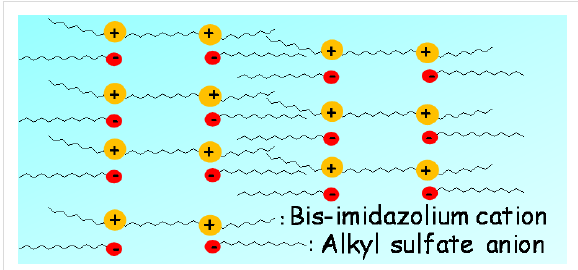
Figure 1: Schematic representation of the bilayer interdigitated SmA phase of the ILC based on bisimidazolium salts with alkyl sulfate ion.